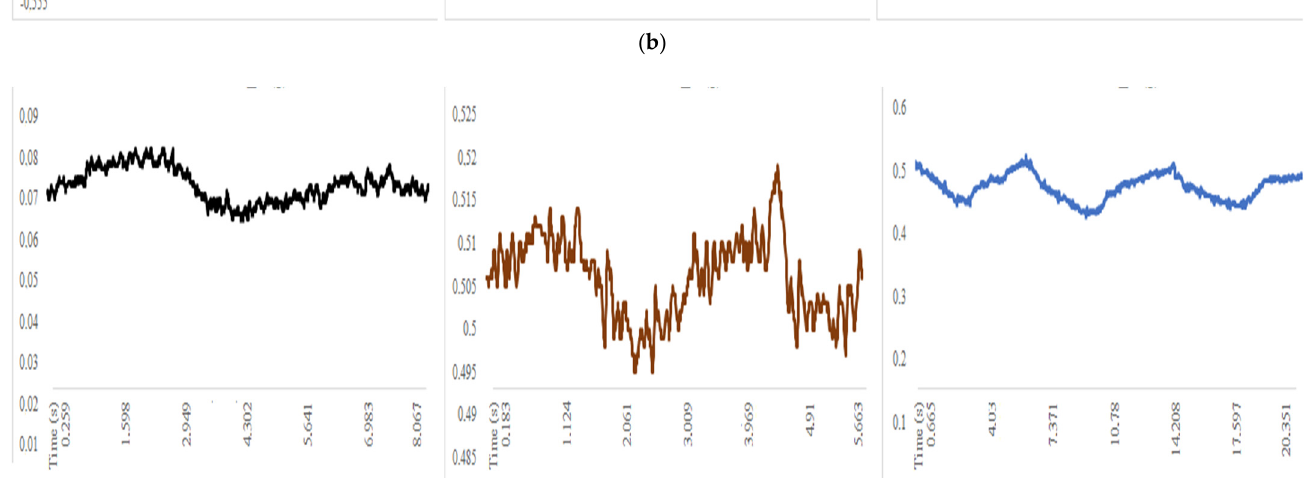
Figure 7. Acquired data by SENSIRIB on the sixth rib on a volunteer for a test in terms of: ( a ) acceleration along X; ( b ) acceleration along Y; ( c ) acceleration along Z (in black for the pre-operative condition, in red for the post-operative condition on the operated side, in blue for the post-operative condition on the non-operated side).